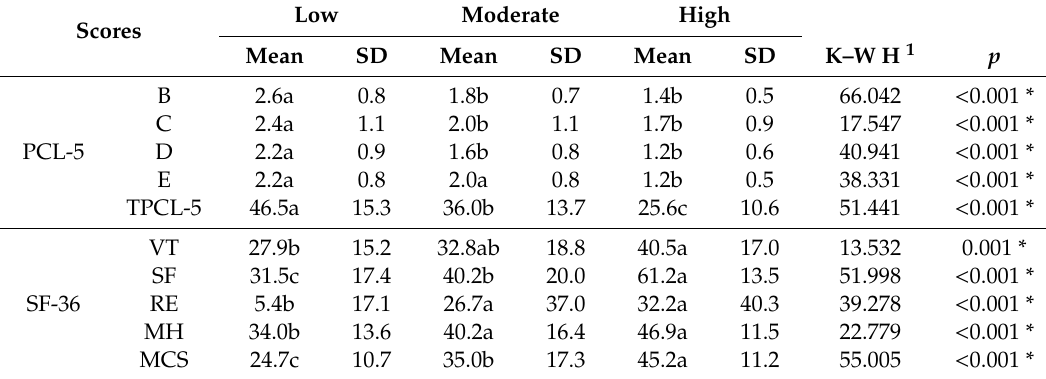
Table 3. Di ff erences in PCL-5 cluster scores and SF-36 health survey scores between groups with di ff erent perceptions of social